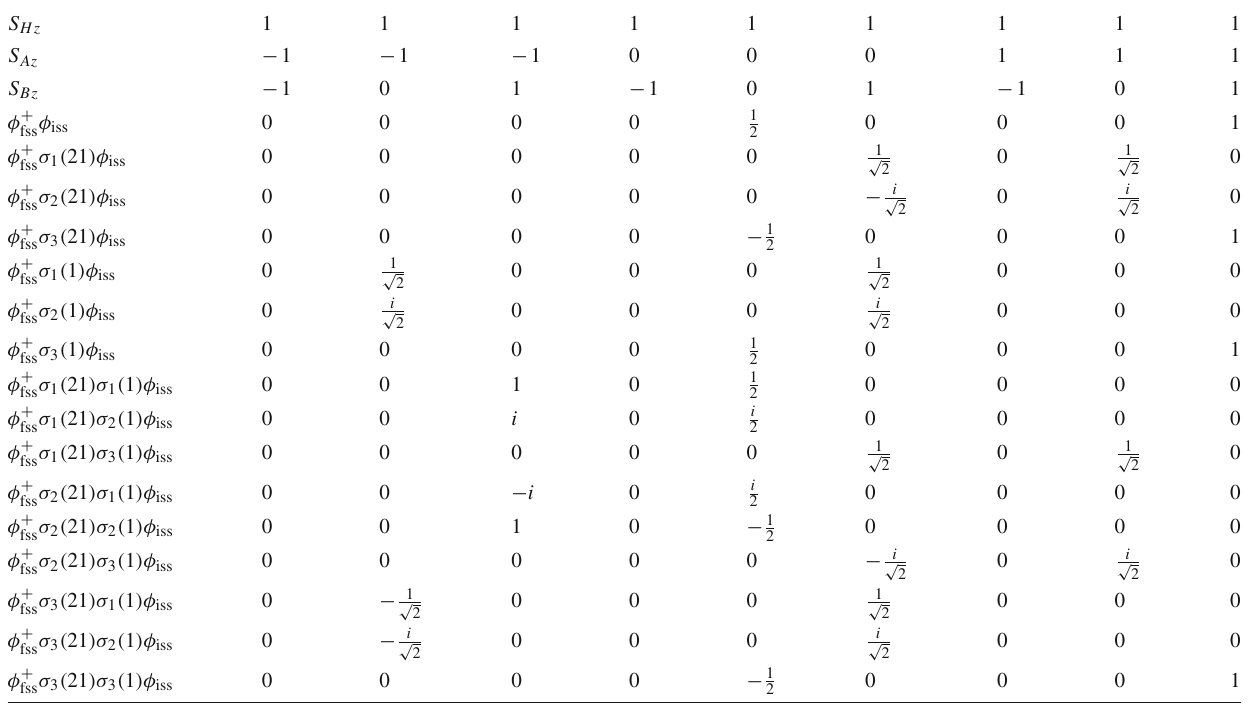
for A ( S A = 1 ) + B ( S B = 1 ) → H ( S H = 1 ) with S Hz = 1 1 ¯ q 2 ¯ q 1